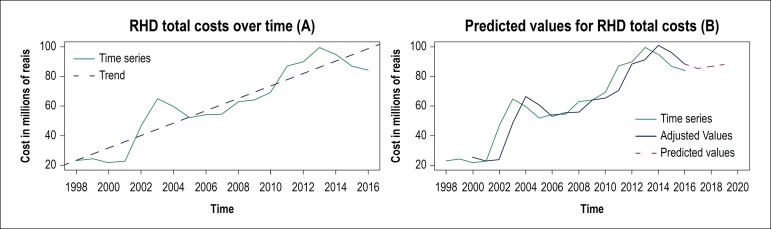
Growth trends (A) and predicted values (B) for total costs with RHD. The
model equation for the total costs with RHD (C) was RDHTC =
–8346,31 + 4,19* Year. It should be noted that all trends were
significant (p-value < 0.050), evidencing the increasing trend of the
series over time.